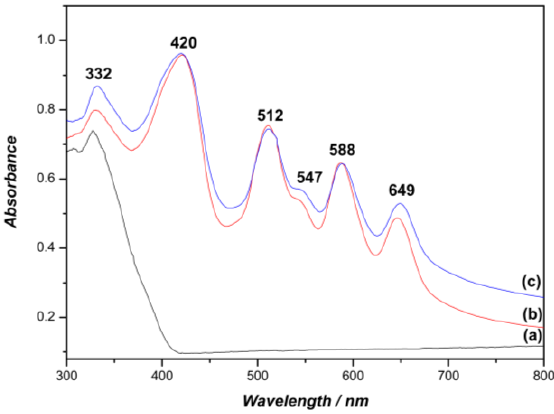
Figure 4. UV-Vis spectra in the solid state of (a) TiO 2 , (b) P3-TiO 2 and (c) P4-TiO 2 .